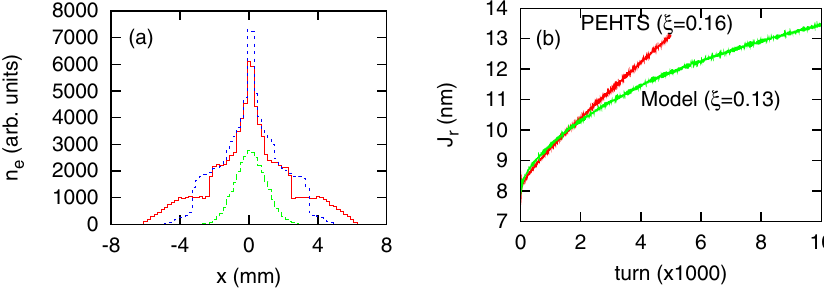
FIG. 20. (Color) Transverse electron distribution during the beam interaction [plot (a)] and emittance growth for single interaction point [plot (b)]. The profile of the beam (green) and electron cloud (red and blue) are plotted in plot (a). Emittance growth given by the PIC simulation and simple model in Sec. V are plotted with red and green lines in plot (b).